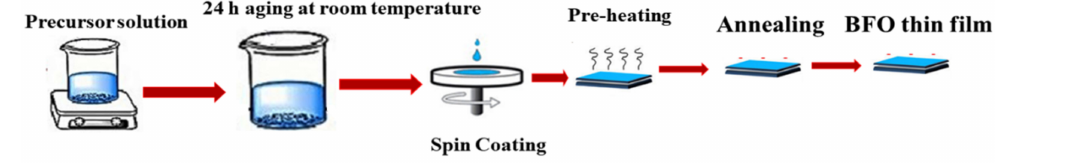
Figure 1. Pictographic representation of fabrication of BFO thin films assembly.